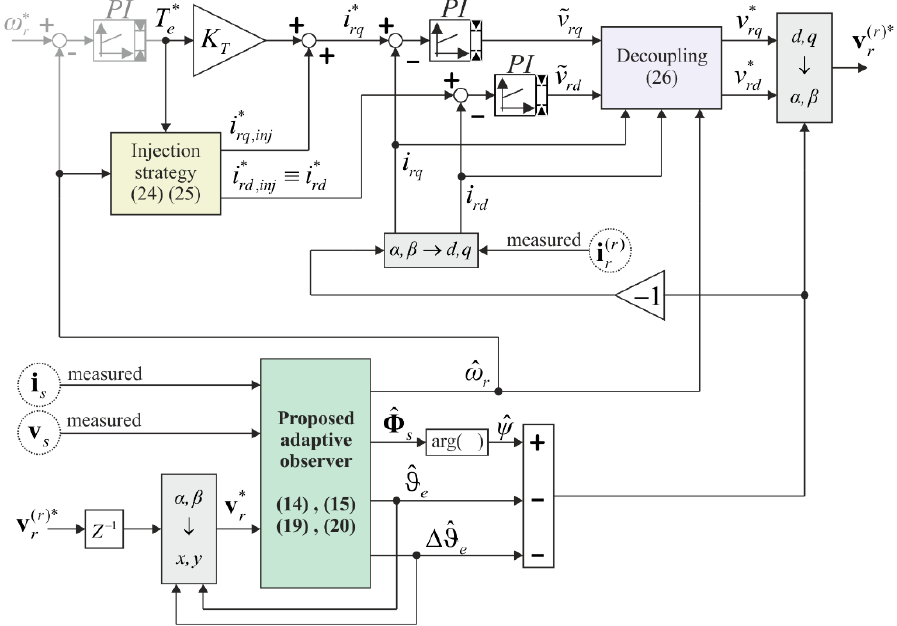
Figure 2. Control diagram.